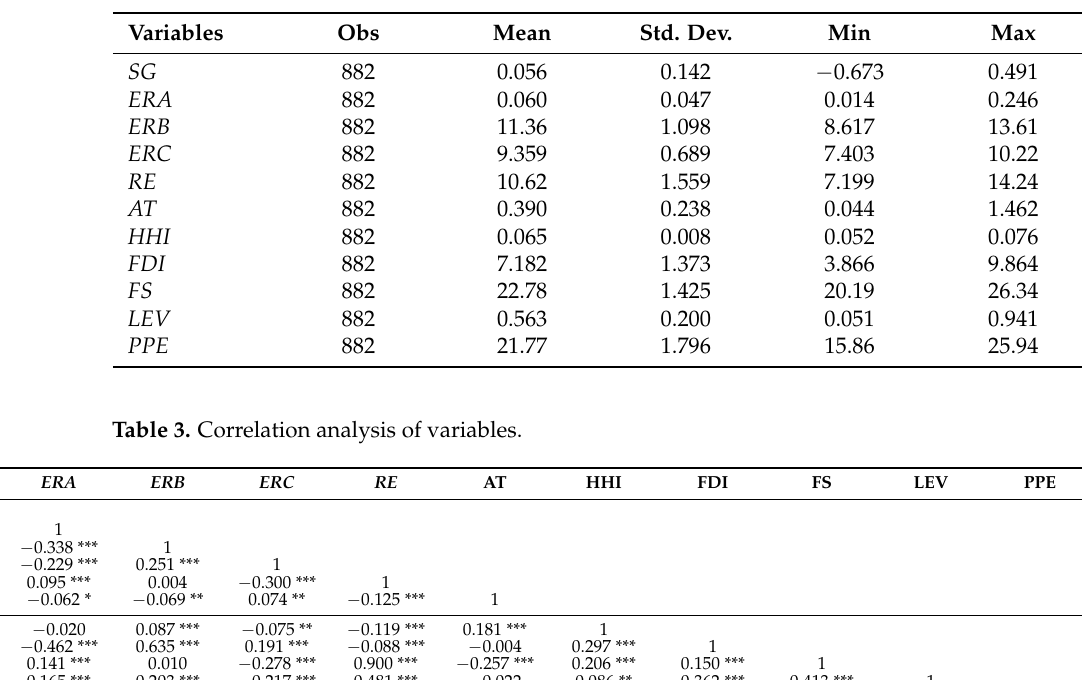
Table 2. Descriptive statistics of variables.